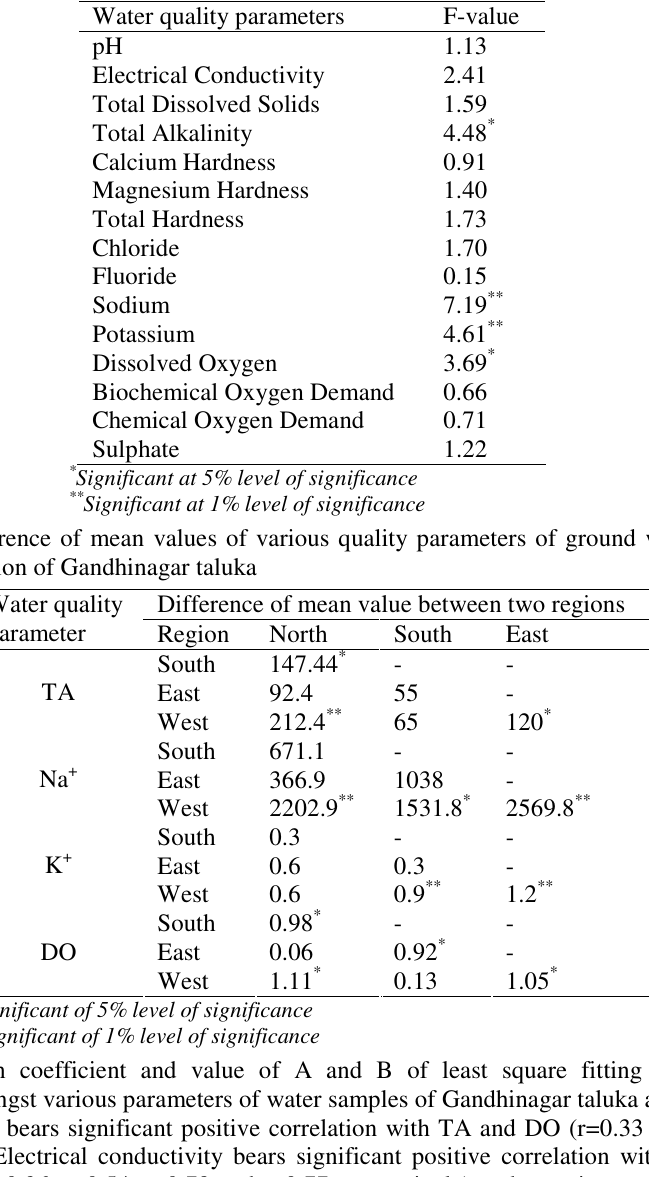
Table7. F value of various quality parameters of ground water of all regions of Gandhinagar taluka in Gujarat